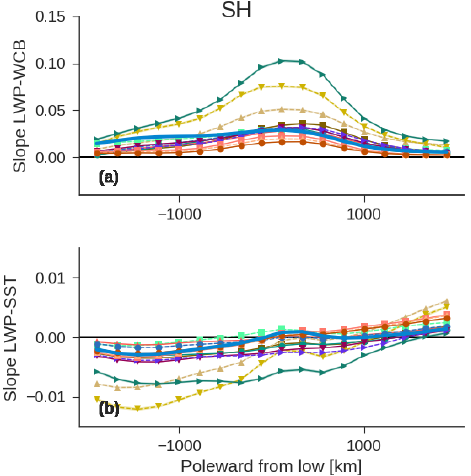
Figure 10. The multiple linear regression slopes from Eq. (6) aver- aged zonally across the composite. The x axis shows distance from the low-pressure center oriented toward the pole. Regression slopes from the NH are shown in (Fig. S13). Panel (a) shows the slope relating the WCB moisture flux into the cyclone and LWP ij (units are kgmmday − 1 m − 2 ). Panel (b) shows the slope of the regression relating SST ij and LWP ij (kgm − 2 K − 1 ). The 95% confidence in- tervals in the zonal-mean regression slope are shown as